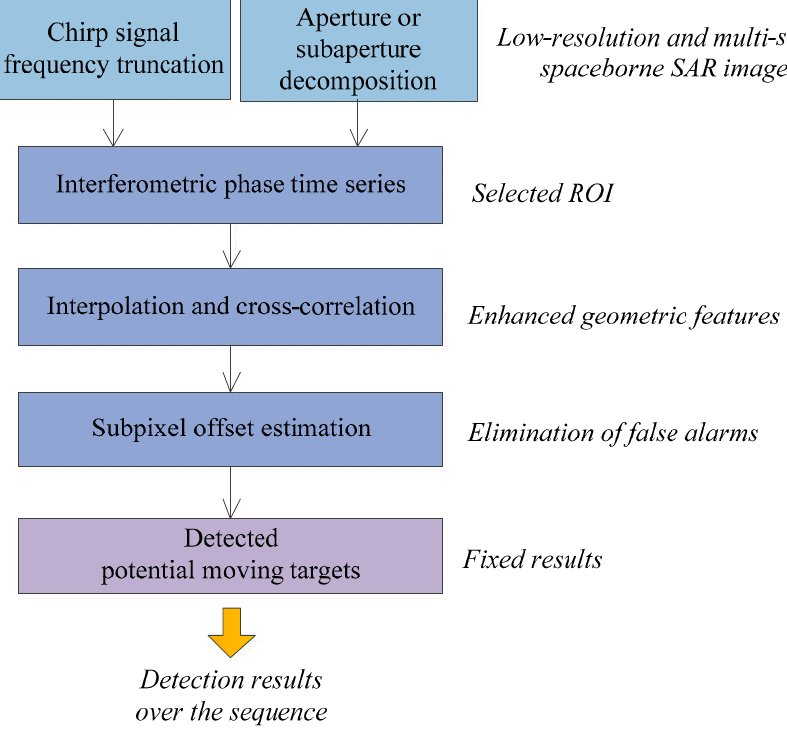
Figure 2. Flowchart of the proposed method.